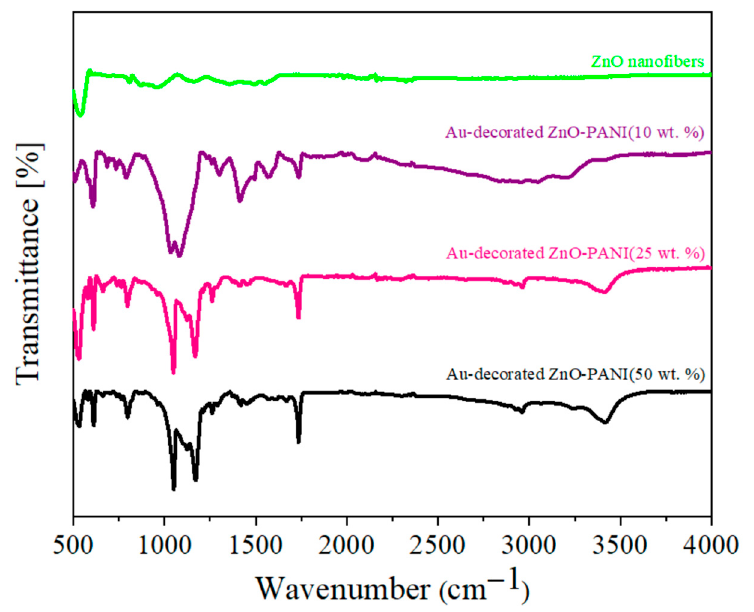
Figure 5. FTIR spectra of Au-decorated ZnO nanofibers and Au-decorated ZnO-PANI composite nanofibers with different amounts of PANI (10, 25, and 50 wt.%).